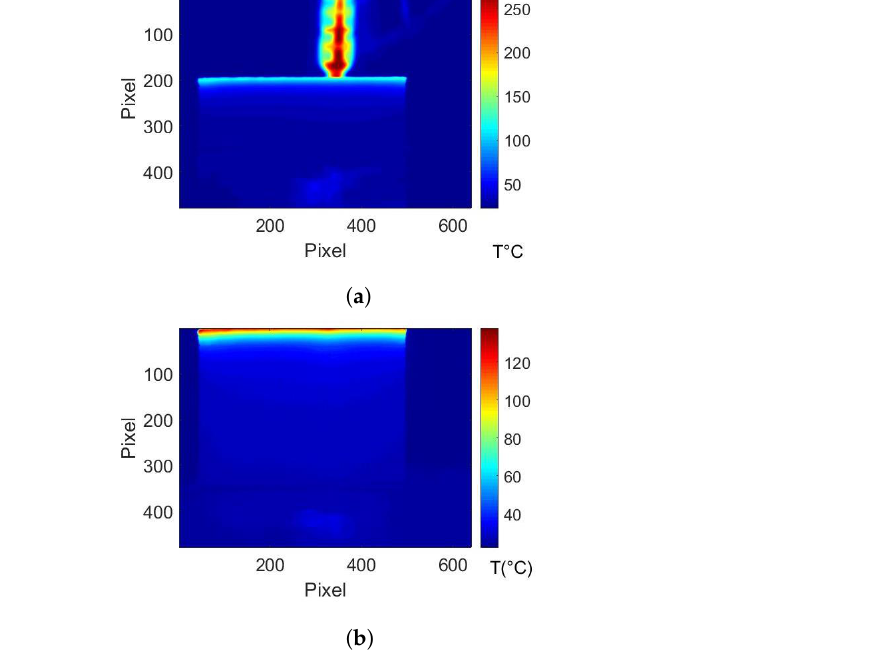
Figure 6. Thermography of the manufactured box: ( a ) at 50% of the process, ( b ) at the end of the